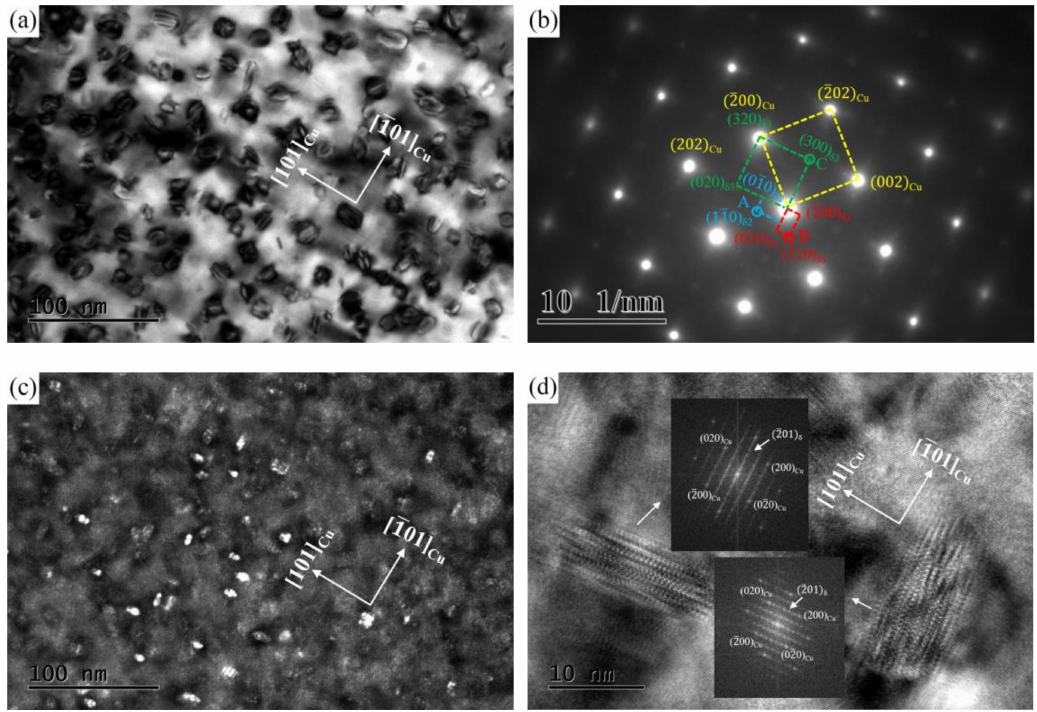
Figure 6. TEM images of the NC-2 alloy aged at 500 ◦ C for 1 h; ( a ) a bright field TEM image along [001] Cu , ( b ) SAED corresponding of ( a ), ( c ) a dark field TEM image of A, and ( d ) an HRTEM image.